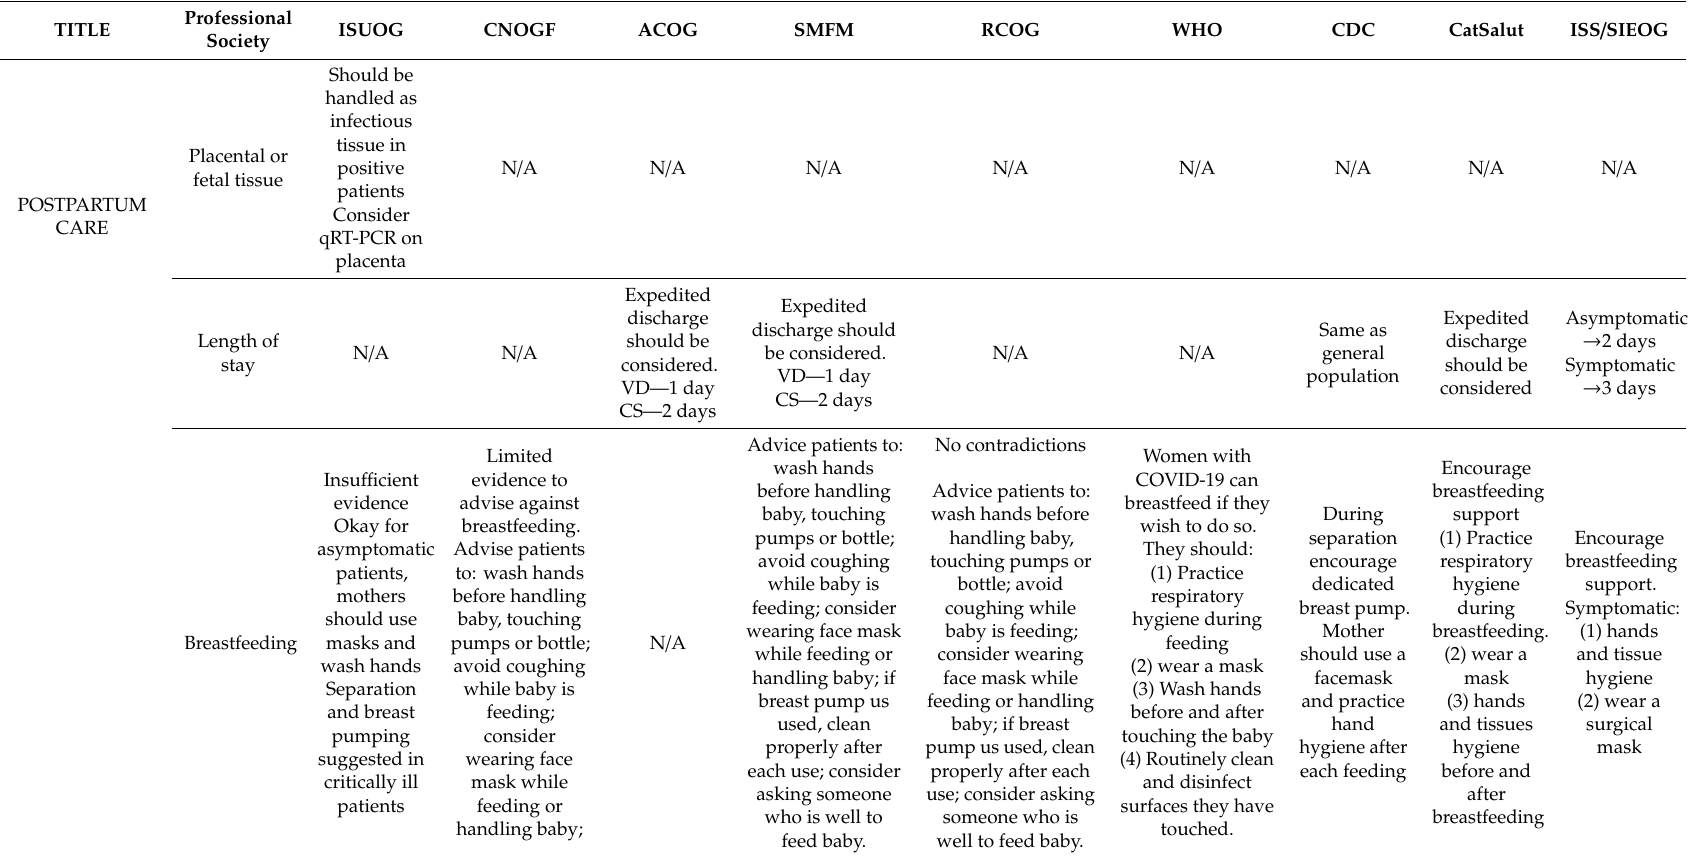
Table 4. Summary of guidelines for postpartum care of pregnant patients during the COVID-19